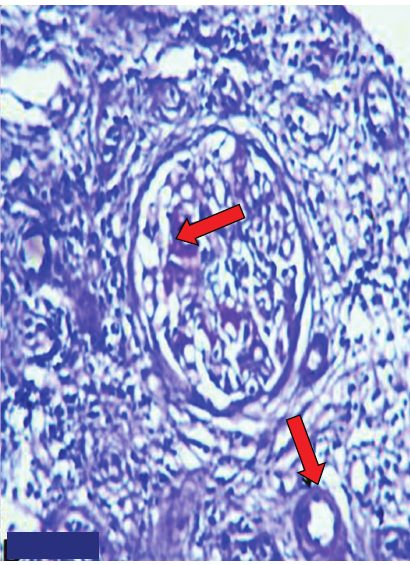
Figure 2: Deposition of amyloid in the focal areas and capillary walls of glomerulus (crystal violet stain ×